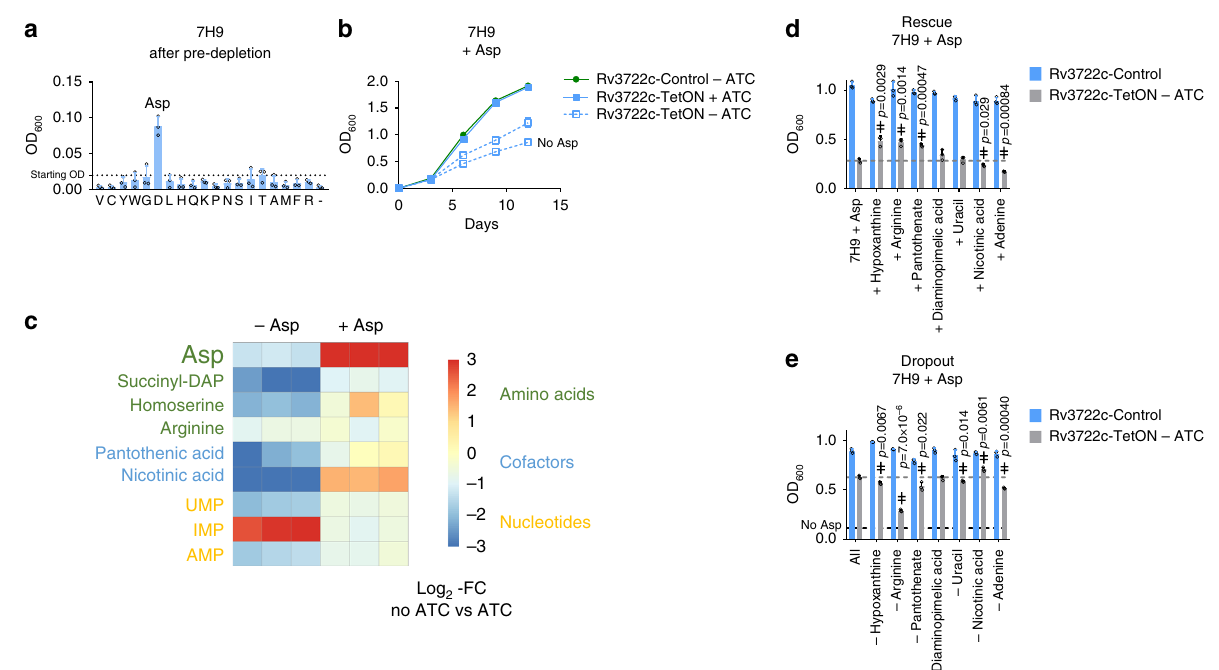
Fig. 7 Aspartate supplementation rescues growth and metabolic defects. a Rescue screen with single amino acids. Rv3722c-TetON was cultured in 7H9 with casein hydrolysate without ATC to predeplete Rv3722c. After predepletion, bacteria were transfered to 7H9 supplemented with 3 mM of the indicated amino acids at a fi nal optical density at 600 nm (OD 600 ) of 0.02. Bacterial growth was measured after 12 days at 37 °C. Amino acids are indicated by their 1-letter code; 7H9 control. b Growth curve of Rv3722c-pro fi cient and -de fi cient Mtb in 7H9 supplemented with Asp. Rv3722c-TetON and Rv3722c-control were cultured in 7H9 supplemented with 3 mM Asp, + / − anhydrotetracycline (ATC). Data from Rv3722c-TetON cultured in the absence of ATC and Asp (Fig. 1a) were plotted as a reference. c Heatmap showing levels of Asp and its essential downstream metabolites. Rv3722c-TetON was cultured in 7H9 (Fig. 1a) or 7H9 supplemented with Asp ( b ) with or without ATC for 12 days. Relative levels of indicated metabolites were determined using LC-MS. Colors indicate log 2 -fold change of the LC-MS peak areas detected without ATC versus those with ATC, in the absence ( − ) or presence ( + ) of 3 mM Asp. d Rescue screen with essential Asp metabolites. As a , but supplementing with diaminopimelic acid, arginine, uracil (at 1 mM) or nicotinic acid, pantothenic acid, adenine, or hypoxanthine (at 0.15 mM), in addition to 3 mM Asp. e Dropout screen with essential Asp metabolites. As d , but supplemented with all but the indicated product. Bacterial growth data in a , b , d , and e are presented as mean + / − SD of three experimental replicates, with individual data datapoints shown as open circles ( a , d , e ). Fold changes are presented as mean of a single ratio ( n = 1 per square). Data are representative of at least two independent experiments. See also Supplementary Fig. 16. Statistically signi fi cant differences between culture media were identi fi ed by a combination of a two-sided unpaired Student's t test ( p < 0.05, as indicated) and Mann – Whitney U rank testing (for which the smallest possible p -value for n = 3 is 0.1) (double dagger); source data are provided as a Source Data fi